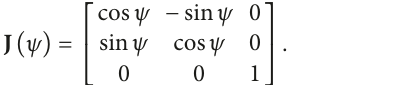
Figure 1. The UMV trajectory is subjected to the